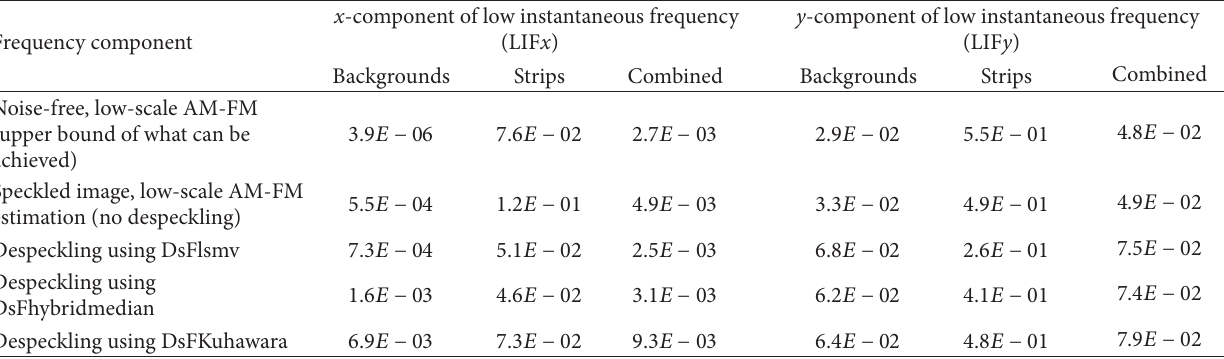
Table 1: Despeckle filtering demonstrating its advantages applied to a synthetic AM-FM example (see text for details). Note significant noise estimation improvements for the narrow strips.